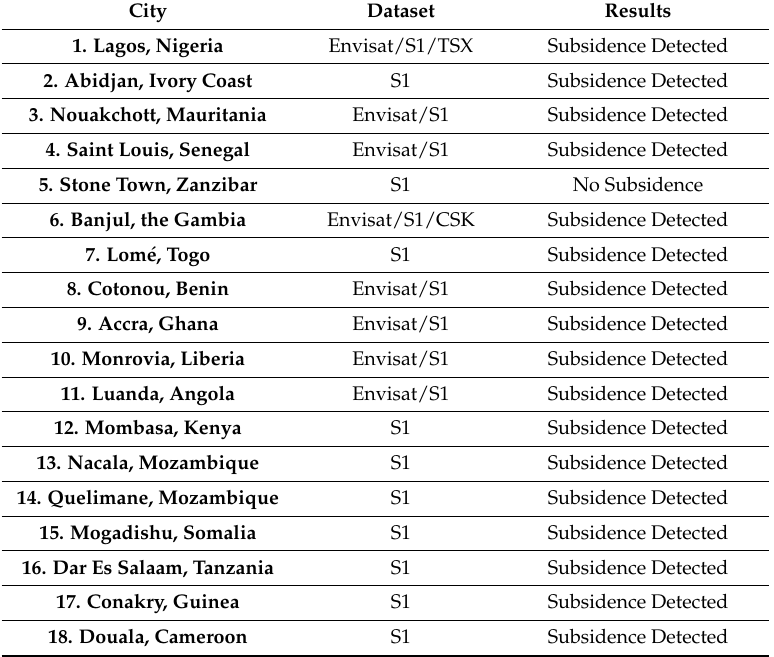
Table 1. Summary of analyzed cities in coastal Africa, datasets employed and short information about the outcomes. Envisat, Environmental Satellite; S1, Sentinel-1; TSX, TerraSAR-X; CSK, Constellation of Small Satellites for the Mediterranean Basin Observation